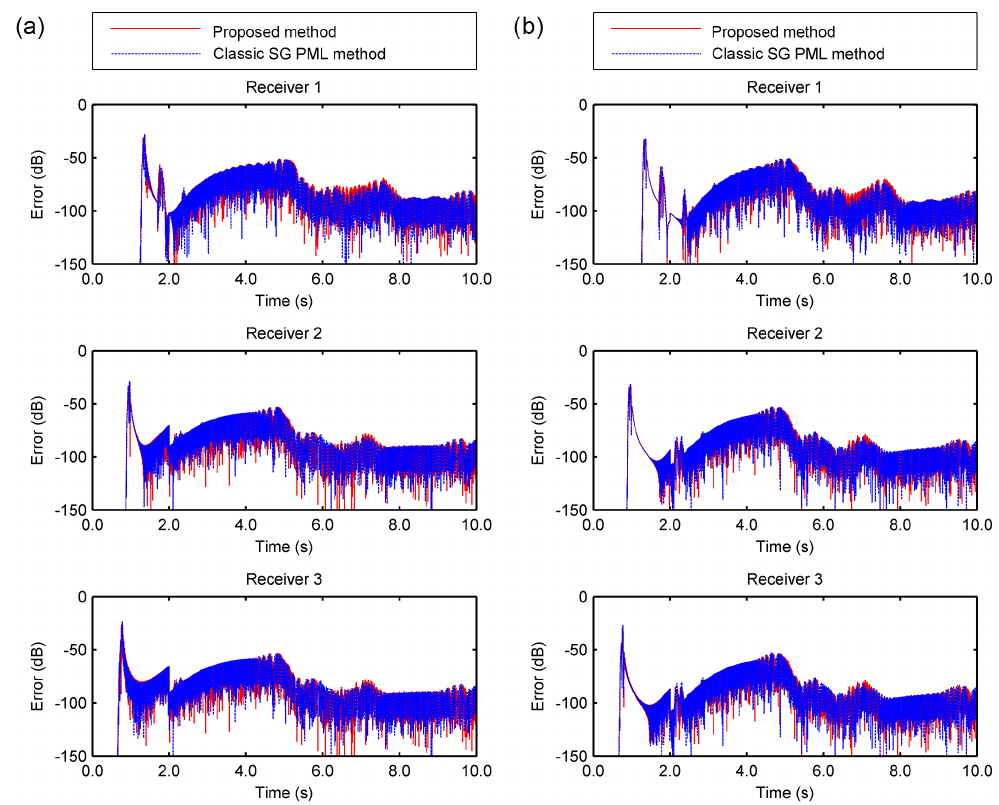
Figure 8. Comparison of the relative errors between the analytical solutions and the proposed method (fourth-order CG scheme) (red solid line) or the classic SG PML method (fourth-order SG scheme) (blue dotted line) at different receivers and different grid spacings. (a) d = 12m, receivers 1, 2, and 3; (b) d = 10m, receivers 1, 2, and